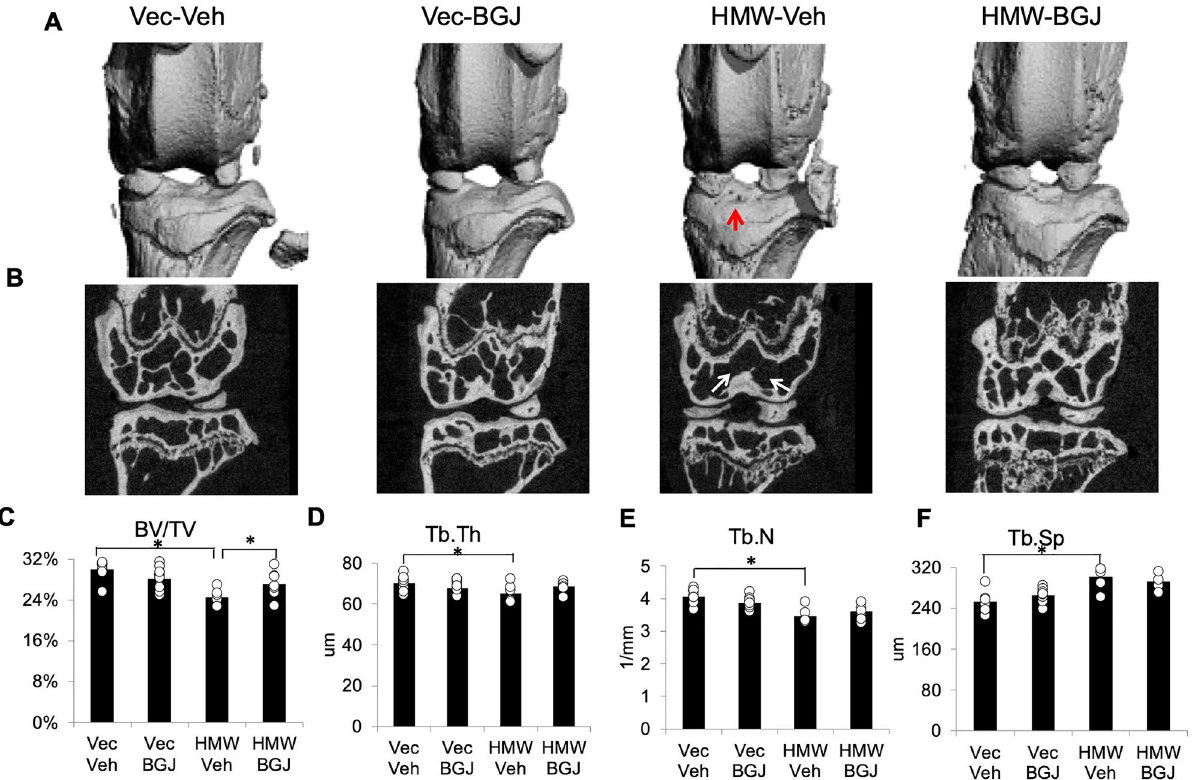
Figure 2. Micro-CT of knees from 9.5-month-old Vector-Control and HMWTgFGF2 mice treated with BGJ398. Eight-month-old Vector-Control (Vec) and HMWTgFGF2 (HMW) female mice were sq injected with vehicle or BGJ398 5 days/week for 6 weeks. Micro-CT analysis was performed at the end of experiment on excised knee joints. ( A ) Representative 3-dimensional Micro-CT images show erosion of articular surface in the HMWTgFGF2 vehicle treated group, that was partially rescued by BGJ398 treatment. ( B ) Representative 2-dimensional Micro-CT images reveal thinning and less subchondral bone in the HMWTgFGF2 vehicle- treated group that was rescued by BGJ398 treatment. Morphometric parameters calculated from 3-dimensional Micro-CT of femoral epiphyses of mice ( C – F ) showed significantly decreased bone volume per total volume (BV/TV), trabecular thickness (Tb.Th), trabecular number (Tb.N), and increased trabecular spacing (Tb.Sp) in femoral epiphysis of HMWTgFGF2 vehicle-treated knees compared with Vector-Control vehicle-treated epiphyses. BGJ398 treatment significantly increased abnormal BV/TV in HMWTgFGF2 mice. Data are shown as mean and individual points. n = 7–9 mice/group. *p < 0.05 by two-way